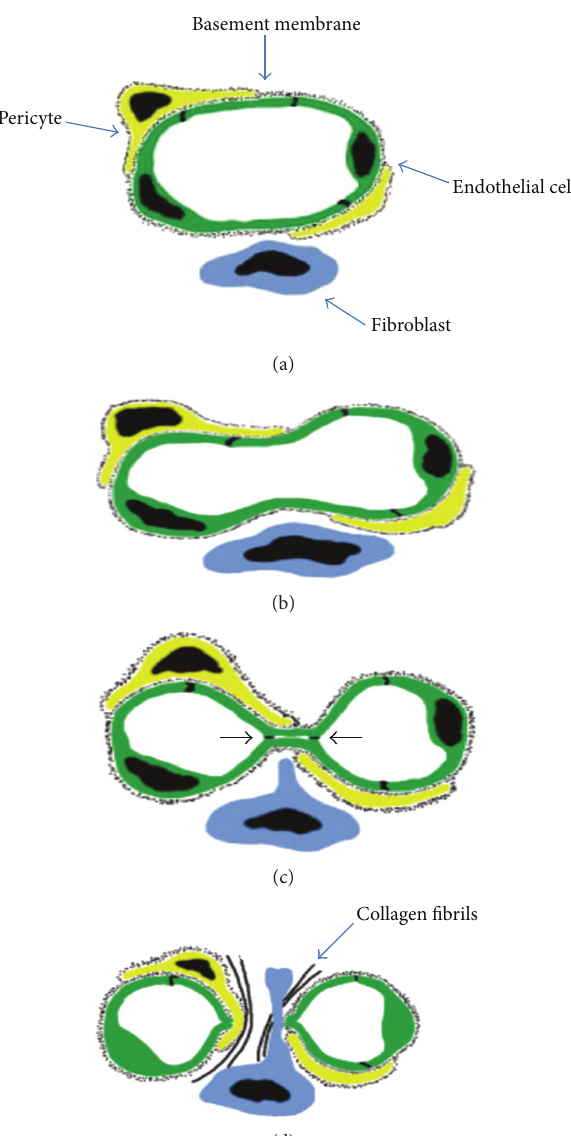
Figure 2: Intussusceptive angiogenesis. Two opposite endothelial cell membranes make contact (“kissing” contact) and interendothe- lial junctions develop at their edge. Connective tissue columns, called tissue pillars, grow into the lumen between the endothelial contact, resulting in partitioning of the vessel lumen (from [28];